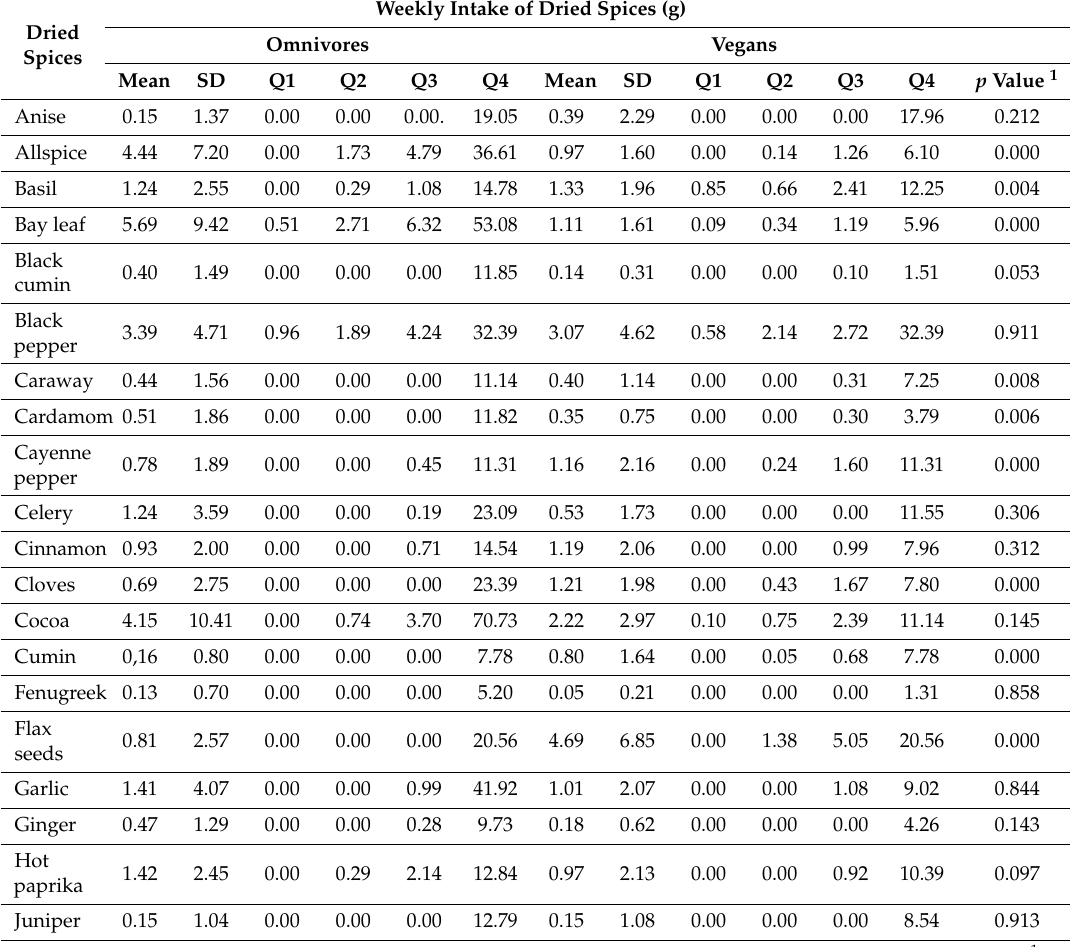
Table 5. Weekly intake of dried spices among adult omnivores and